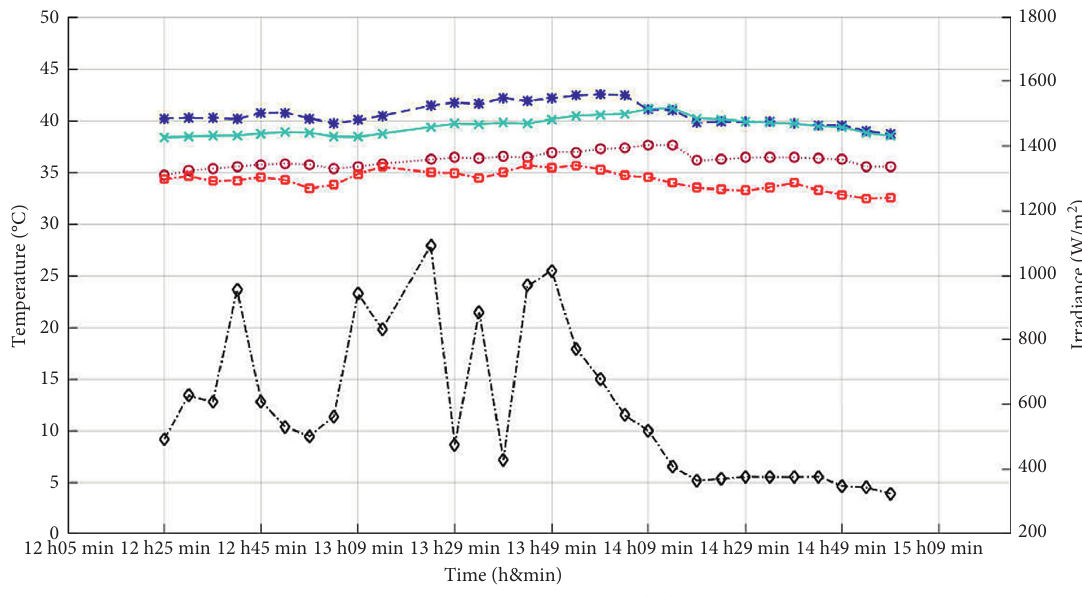
Figure 9: Temperature and irradiance profiles in crossing mode with